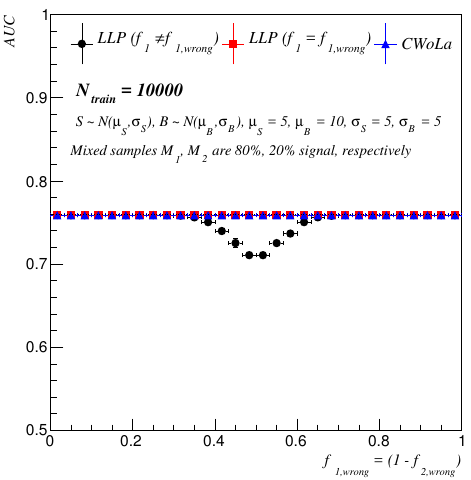
Figure 3 . The AUC for LLP and CWoLa as a function of the (possibly incorrect) signal fraction provided for training. By construction, CWoLa does not depend on the input fraction and LLP is only sensitive to provided signal fraction information when that fraction is near